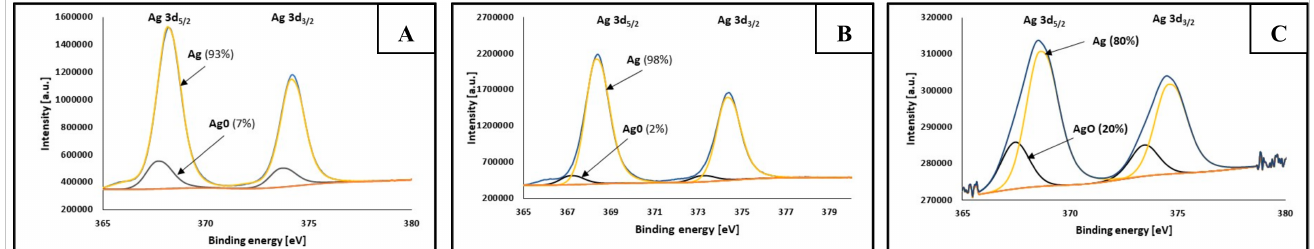
Figure 8. XPS spectra of Ni-Ag NPs with different sizes—analysis of silver: ( A ) 100 nm; ( B ) 220 nm; ( C ) 420 nm (spectra bands: metallic Ag—yellow curve, AgO—black